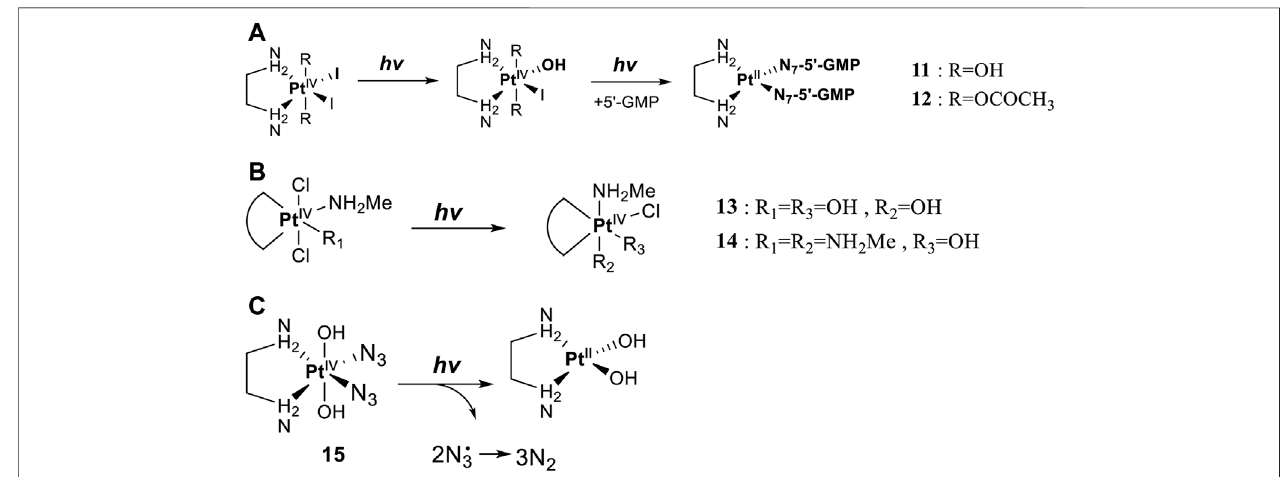
FIGURE 2 | (A) Proposed photochemical reaction pathway of 11 and 12 in the presence of 5 ′ -GMP (adapted from Kratochwil et al. (1999)). (B) Proposed photo- inducedisomerizationmechanismof 13 and 14 (adapted fromNakabayashietal.(2007)). (C) Photolysisofcomplex 15 (adapted fromBednarskietal.(2006);Bednarski et al.